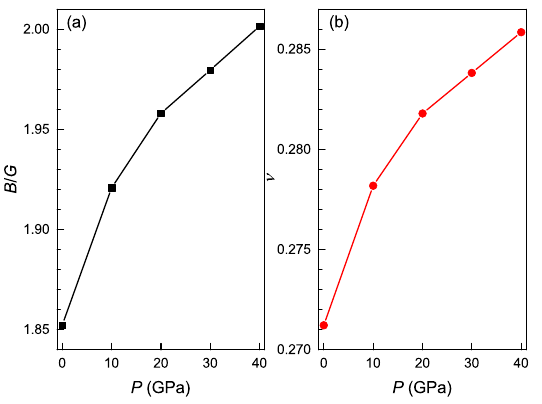
Figure 6. Ratio of bulk modulus to shear modulus ( a ) and Poisson’s ratio ( b ) as a function of pressure for the Ti 4 Nb 3 Al 9